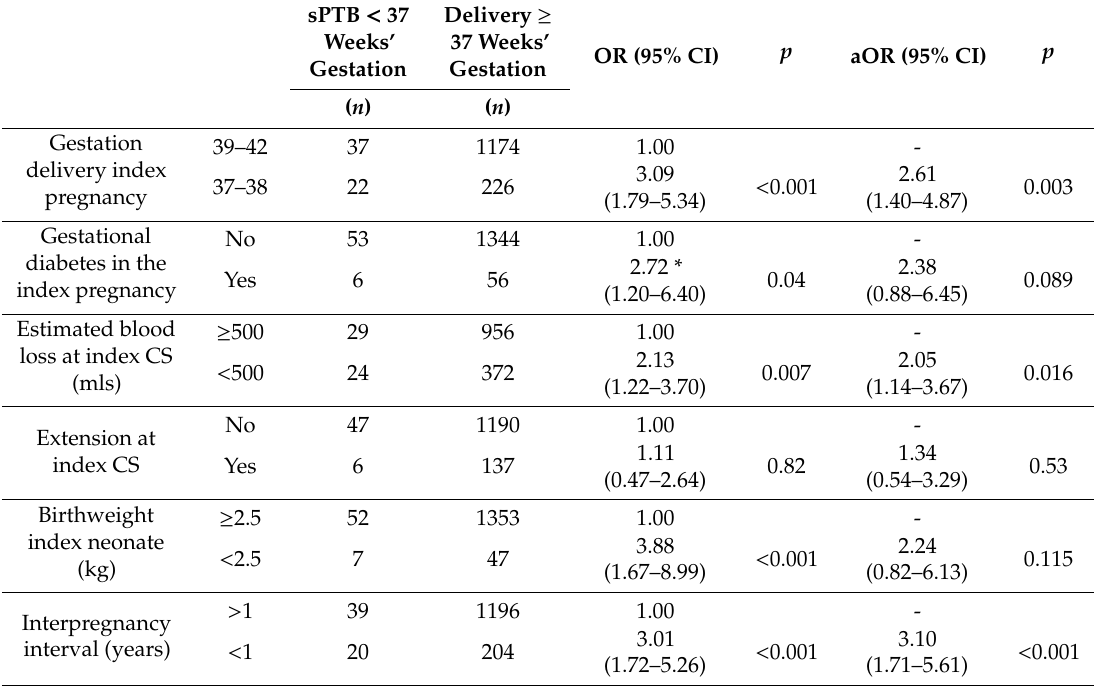
Table 2. Odds ratio for all baseline variables found to increase the risk of spontaneous preterm birth in a subsequent pregnancy. sPTB: spontaneous preterm birth; CS: caesarean section; OR: odds ratio; aOR: adjusted odds